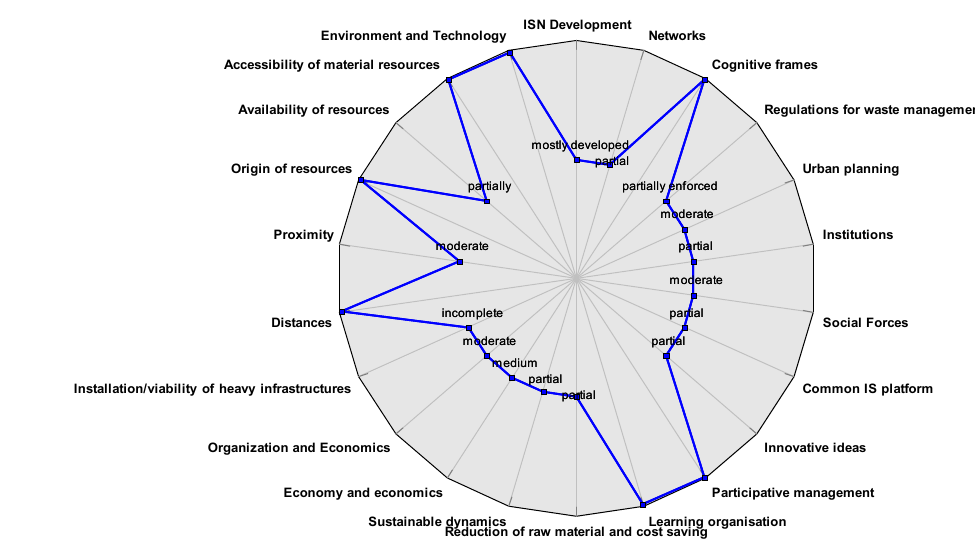
Figure 3. Polar chart of the selected attributes for ISN in Aalborg.